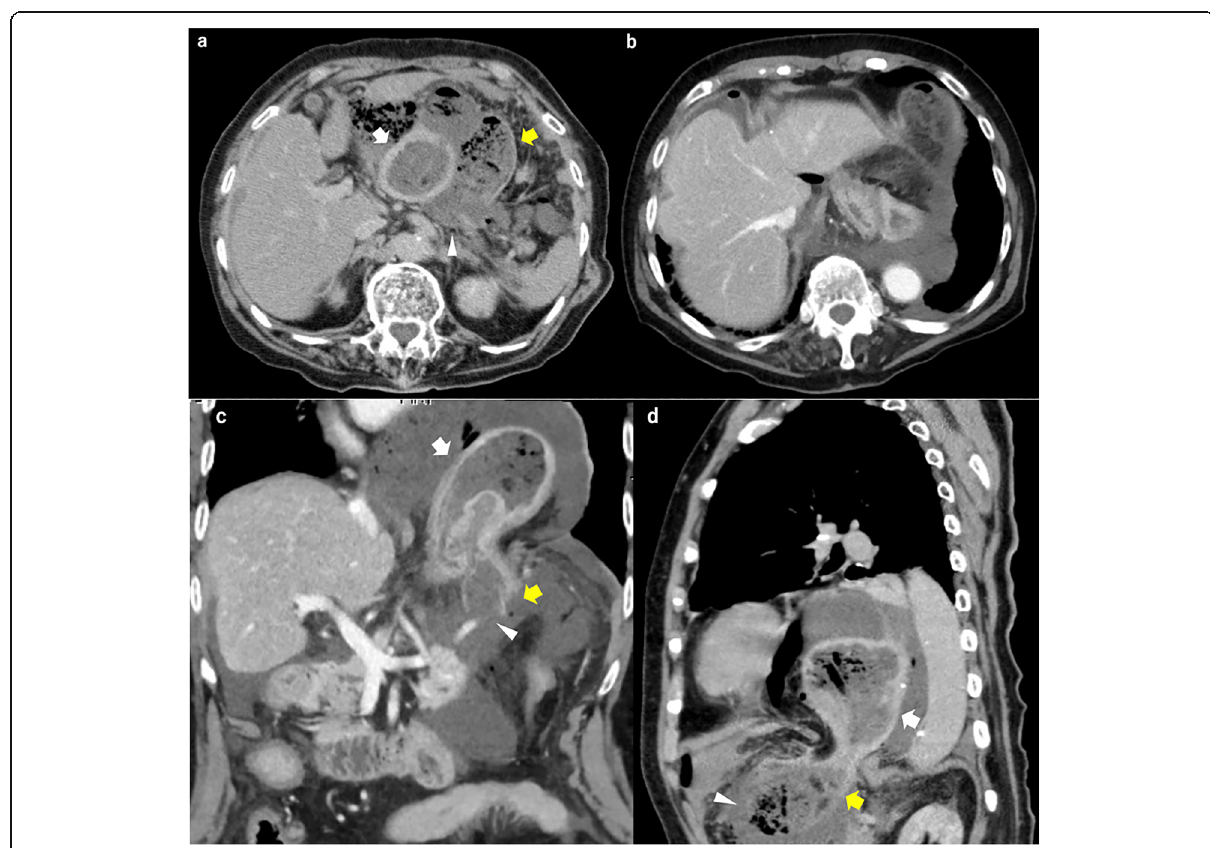
Fig. 1 Preoperative computed tomography scan. Preoperative computed tomography scan ( a , c , d ) showing the gastric fundus and upper body incarcerated within the hiatal hernia (white arrow). The perforation (arrowhead) was located at the fundus outside the sac, which was locally ischemic and necrotic owing to complete cessation of blood supply (yellow arrow). All arteries, including the short gastric artery, were not clear on computed tomography, but arteries flowed into the sac at the hernia orifice ( b , c , d ) and